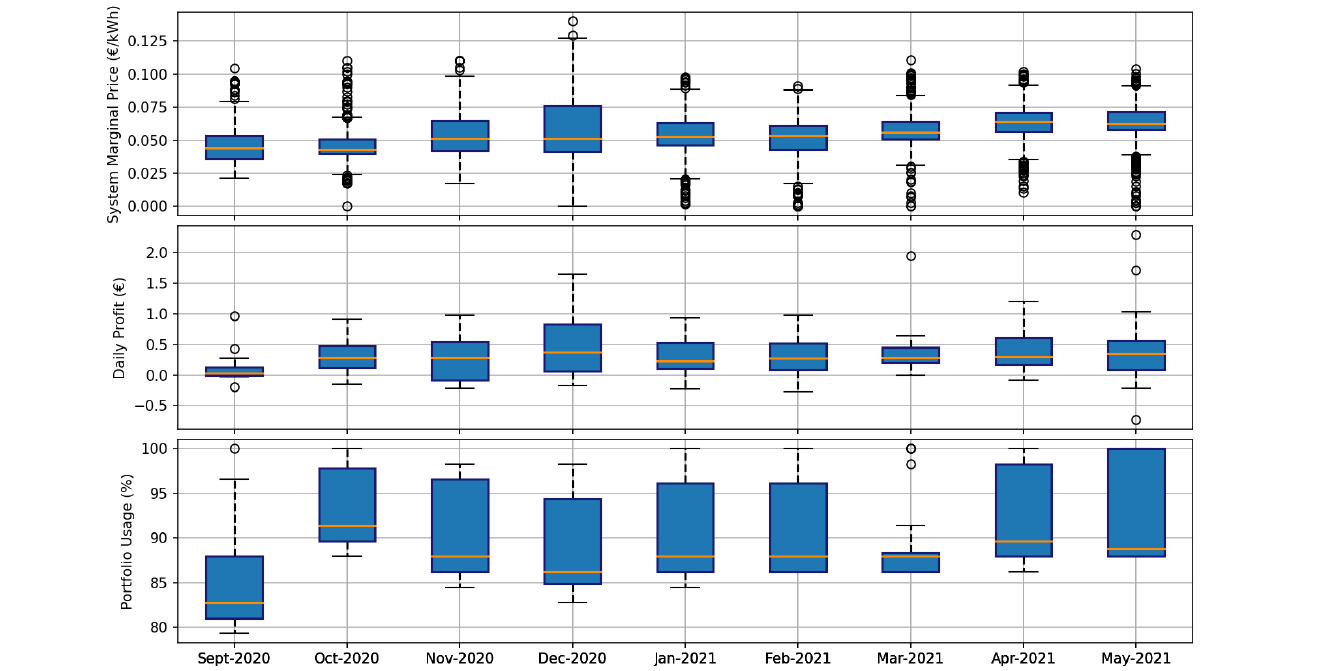
Figure 7. Boxplots of three key variables throughout the simulation